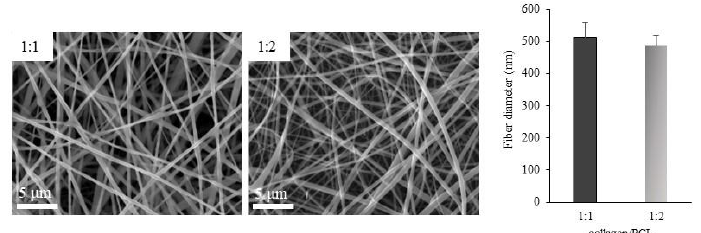
Figure 5. Morphological (on the left) and dimensional (on the right) characterization of the nanofibers based on collagen/PCL mixtures 1:1 and 1:2 (w/w).